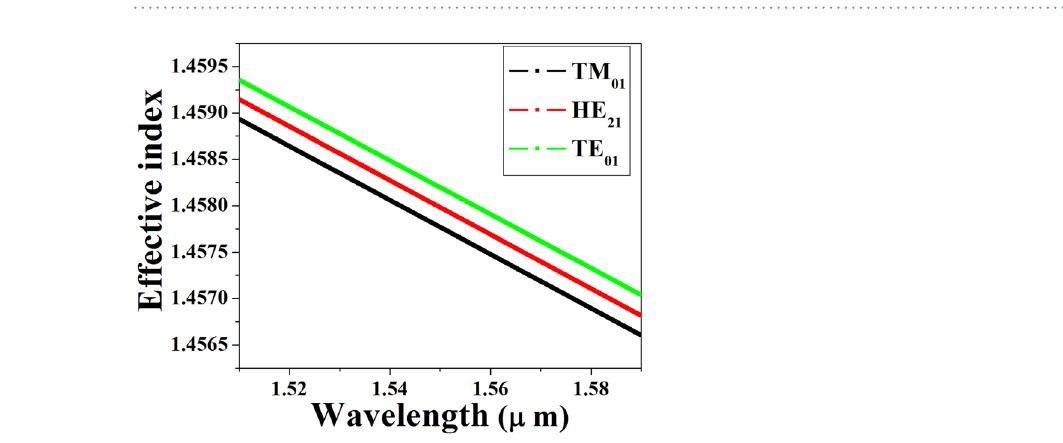
Figure 5. ERIs of the vector modes in the LP 11 group calculated via FEM simulations based on the measured RIP of the